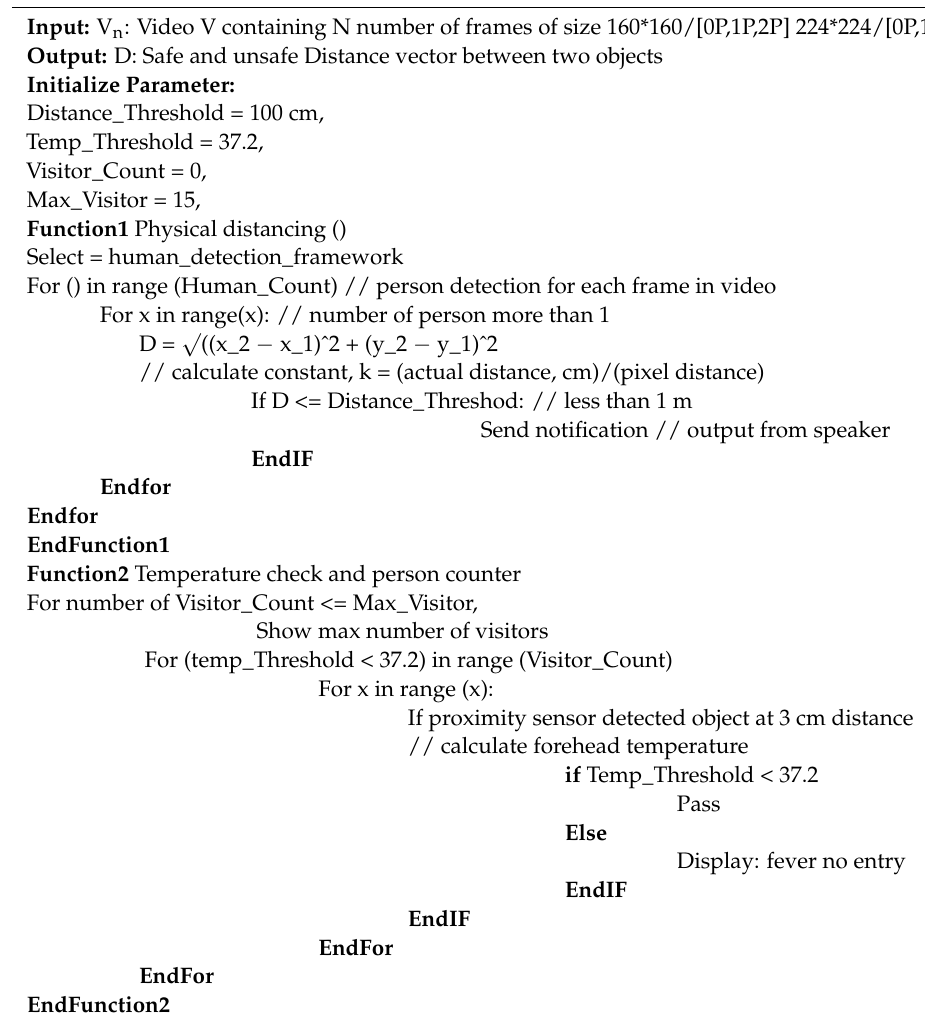
Algorithm 1. Physical Distancing